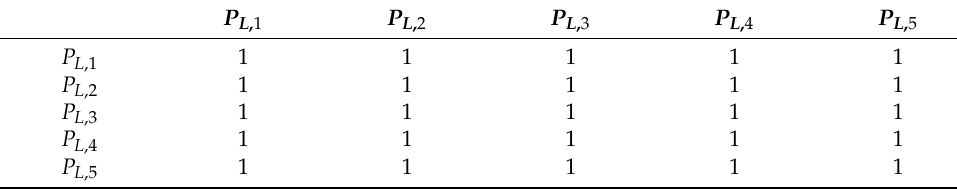
Table 10. Judgment matrix in the indicator layer ( P L ,1 – P L ,5